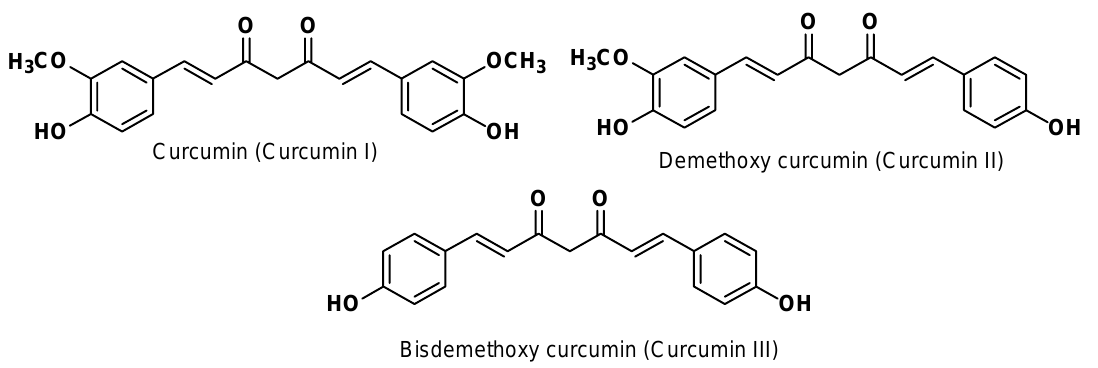
Figure 2. Structure of three major curcuminoids in